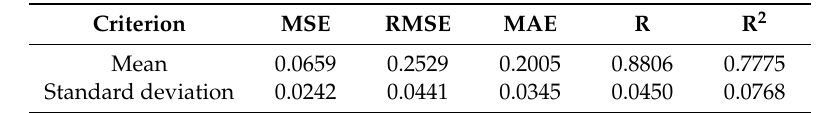
Table 3. Mean and standard deviation of the performance evaluation parameters of the hybrid ANN–ABC method in estimating the BrimA property on the spectral data around the wavelength of 962 nm for the 1000